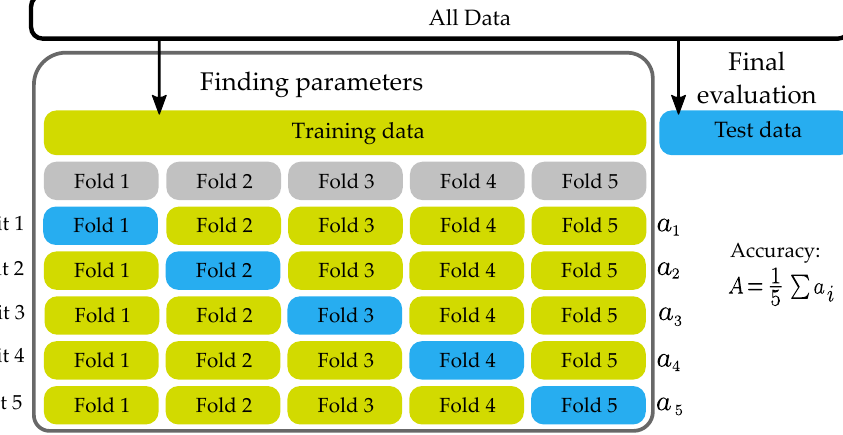
Figure 6. Five fold